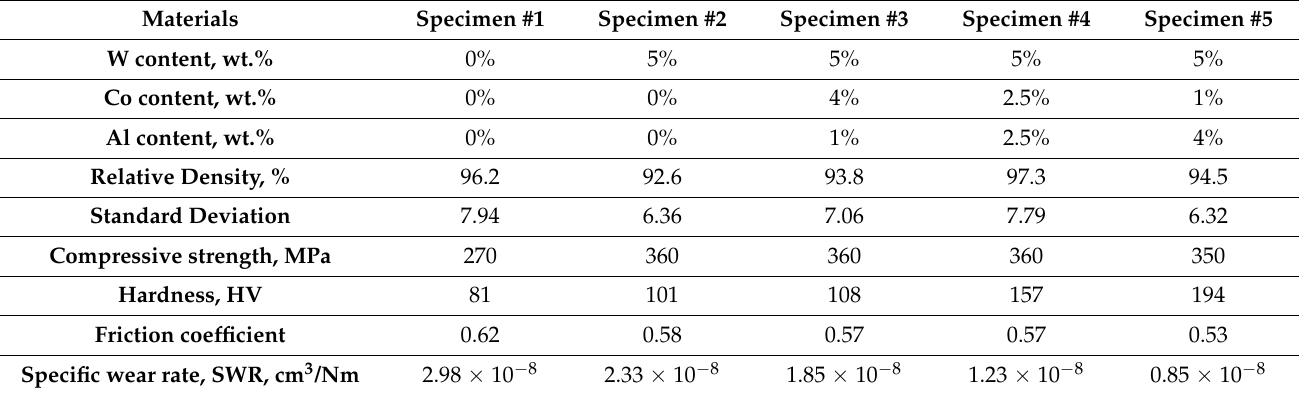
Table 4. Characteristics of the tested bearing